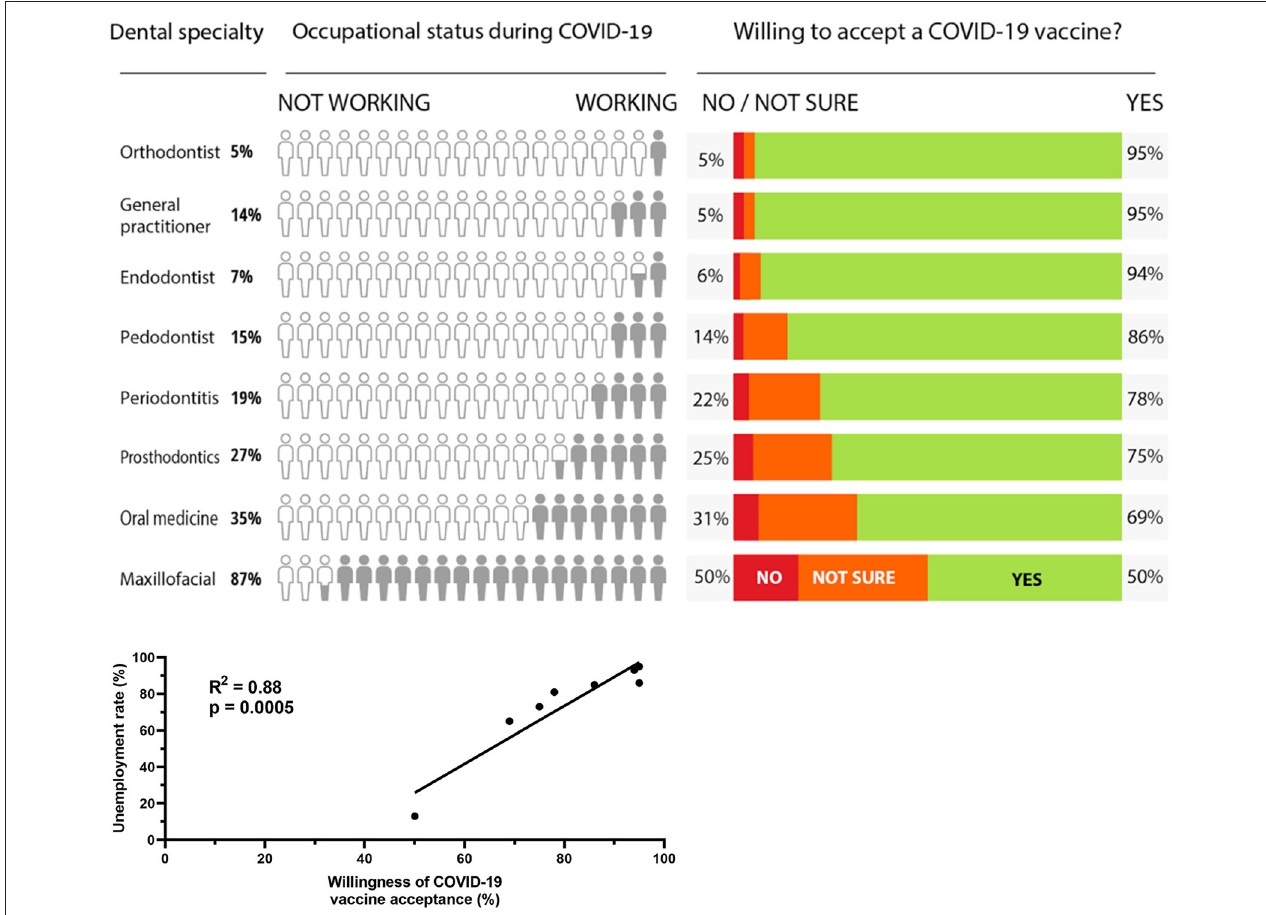
FIGURE 1 | We estimated the strength of the association between willingness of COVID-19 vaccine acceptance and unemployment rate by using Pearson’s correlation coefficient ( r = 0.9414). We used GraphPad Prism version 8.2.1 (GraphPad Software, La Jolla, CA, USA) for correlation analyses.